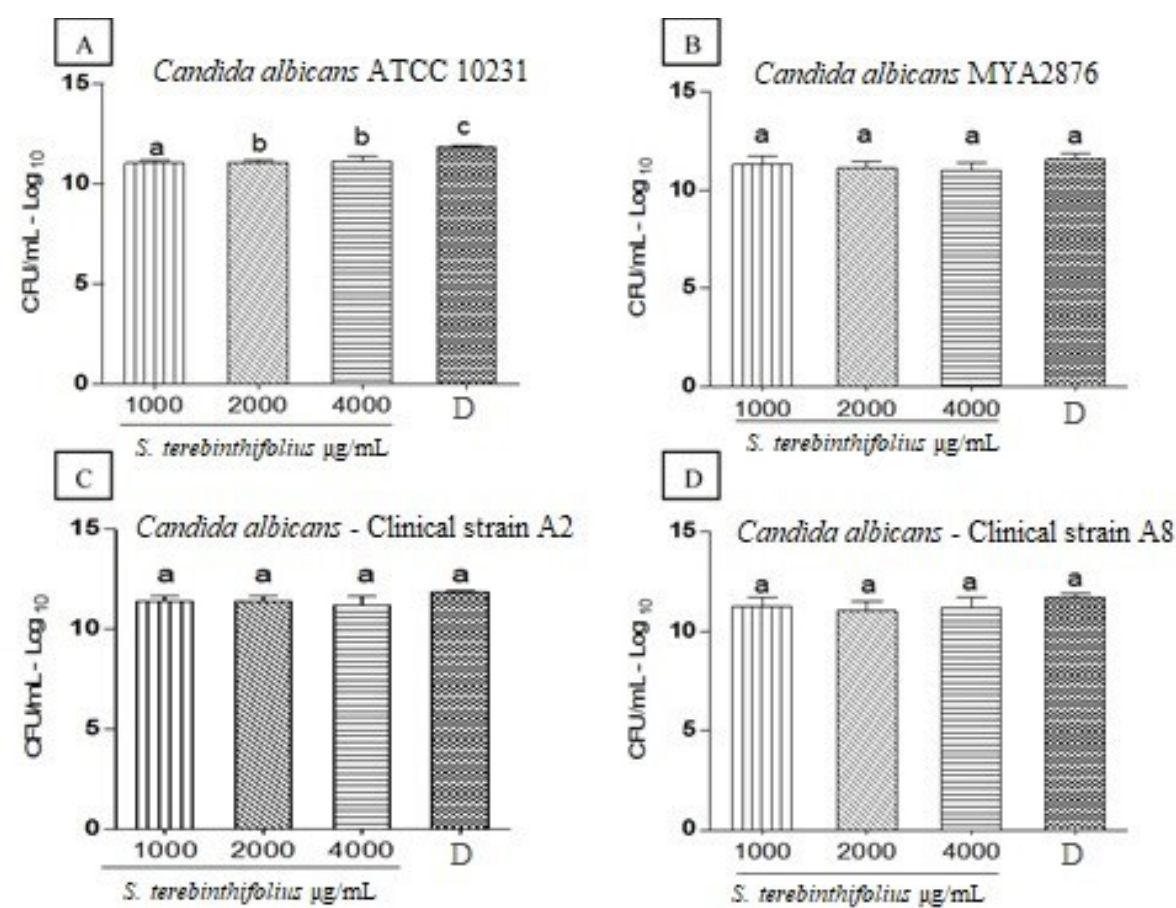
FIGURE 1 - Anti-biofilm activity of S. terebinthifolia green fruits EO at concentrations 1000 μg/mL (MIC), 2000 μg/mL (twice MIC) and 4000 μg/mL (four times MIC) on C. albicans